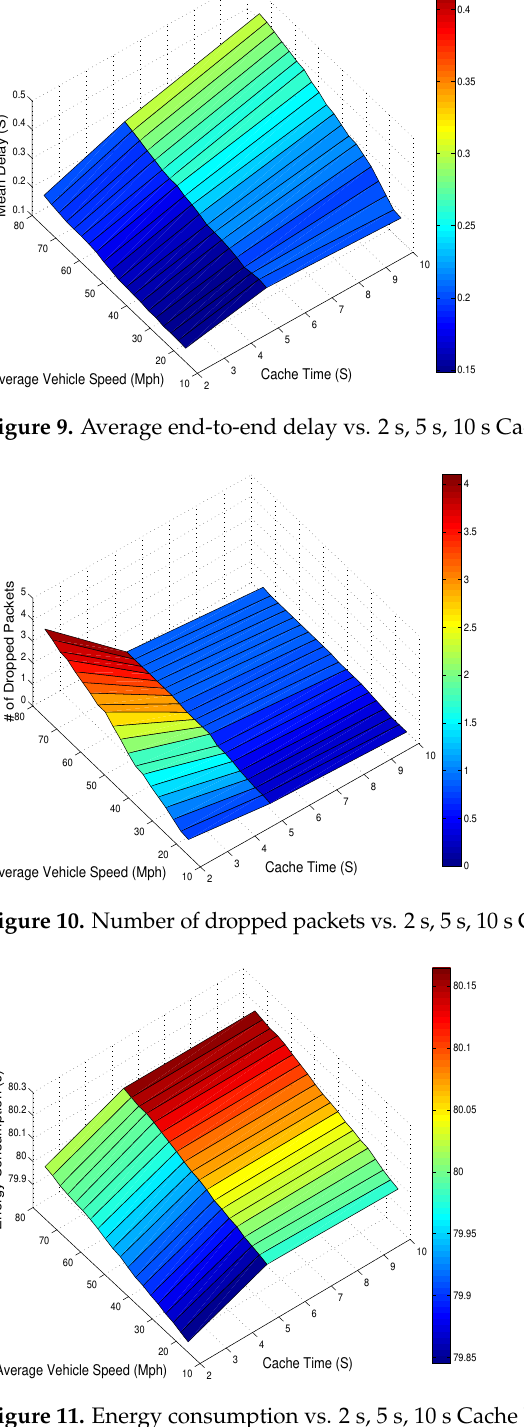
Figure 11. Energy consumption vs. 2 s, 5 s, 10 s Cache Time and Average Vehicle Speed